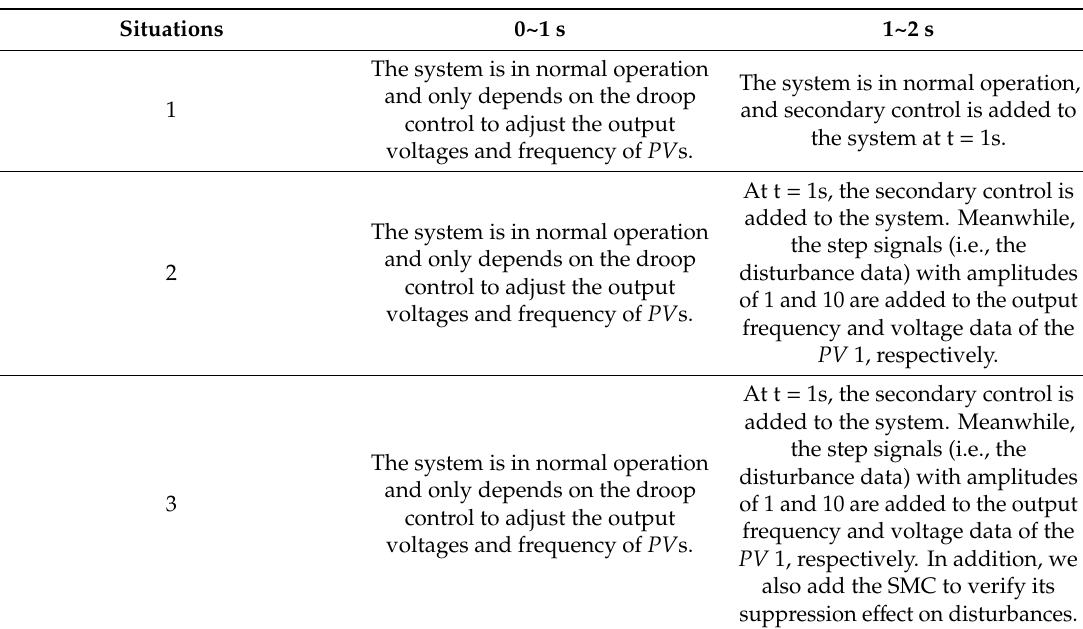
Table 3. The operation process in Case 1.